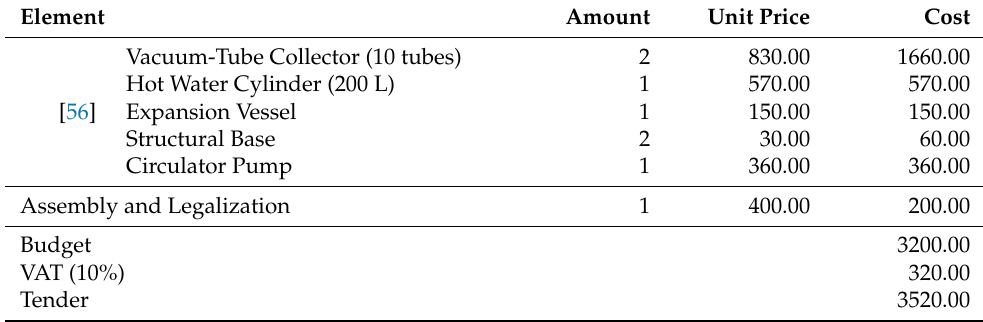
Table 5. Initial costs from ST system.